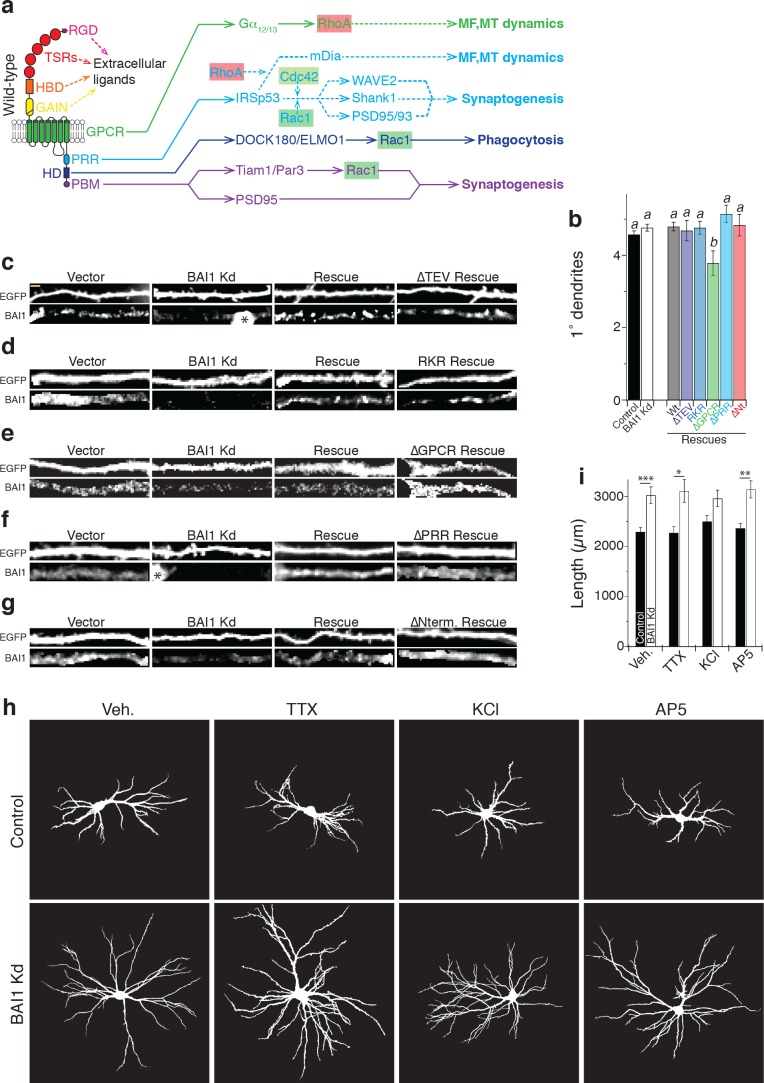
Signaling pathways downstream of BAI1; 1° dendrites in molecular replacement studies; and effect of activity on arbor form.(a) Cartoon showing the domain structure of BAI1 (left), along with functions traced to different intracellular domains of BAI1. Connections depicted in solid lines indicate published connections to BAI1, while dotted lines show published relationships between downstream effectors of BAI1 and other signaling components that have not (yet) been definitively linked to BAI1. Abbreviations: RGD: arginine-glycine-aspartate integrin-binding motif; TSRs: thrombospondin repeats; HBD: hormone-binding domain; GAIN: G-protein autoproteolysis inducing domain; GPCR: G-protein coupled receptor domain; PRR: proline-rich region; HD: helical domain; and PBM: TEV-based PDZ-binding motif (Park et al., 2007; Duman et al., 2013; Zhu et al., 2015; Duman et al., 2016; Stephenson et al., 2013; Ridley, 2006; Kang et al., 2016). (b) Summary data for 1° dendrite number in the molecular replacement studies shown in Figure 6. aP >0.05 within group a, but p<0.05 vs. group b; bP >0.05 within group b, but p<0.05 vs. group a. Total number of neurons is the same as in Figure 5. c through g Representative images of sections of dendrites from the neurons in Figure 6 with BAI1 staining. These images are digital enlargements of the neurons shown in the figure to indicate relative BAI1 levels. Panel c shows the experiment with the ∆TEV mutant, panel d with the RKR mutant, panel e with the ∆GPCR mutant, panel f with the ∆PRR mutant, and panel g with the ∆Nterm. mutant. In panels c and f, the dendrite segment impinges on the cell body of an untransfected neuron, indicated by a *. These images show that the neurons shown in Figure 5 express the appropriate levels of BAI1 for their respective conditions. (h) Representative images of hippocampal neurons transfected pSuper or shRNA against Adgrb1 (BAI1 Kd) and treated with the indicated drugs at 17 DIV and imaged at 21 DIV. Treatments included a vehicle control (Veh.), tetrodotoxin to silence neurons (TTX), potassium chloride to increase neuronal excitability (KCl), and AP5 to block NMDA receptors (AP5). All images were masked to exclude axons and dendrites from other neurons. (i) Summary data of arbor length. Total number of neurons: 95 for control vehicle, 81 for BAI1 Kd vehicle, 41 for control TTX, 49 for BAI1 Kd TTX, 69 for control KCl, 54 for BAI1 Kd KCl, 75 for control AP5, and 63 BAI1 Kd AP5 (N = 5). Data are represented ± s.e.m. . (***p<0.0001, **p<0.01, *p<0.05) Detailed statistics are found in Figure 5—figure supplement 1—source data 1.10.7554/eLife.47566.040Figure 5—figure supplement 1—source data 1.Statistical summary for Figure 5—figure supplement 1 and summary of ANOVA and key Tukey post-hoc tests and N and n values for Figure 5—figure supplement 1b, i.